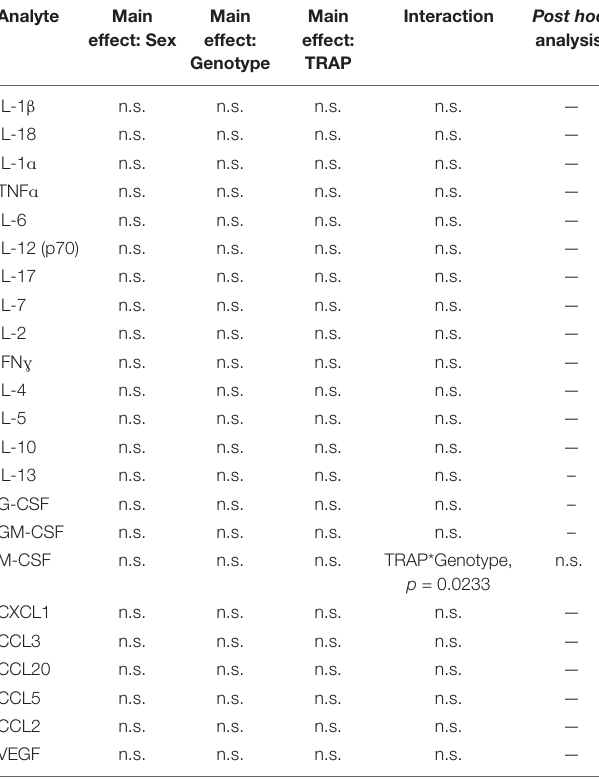
TABLE 3 | Summary of statistical comparisons for levels of cytokines, chemokines, and growth factors in the hippocampus of 10-month-old TgF344-AD and WT rats exposed to TRAP or FA for 9 months.